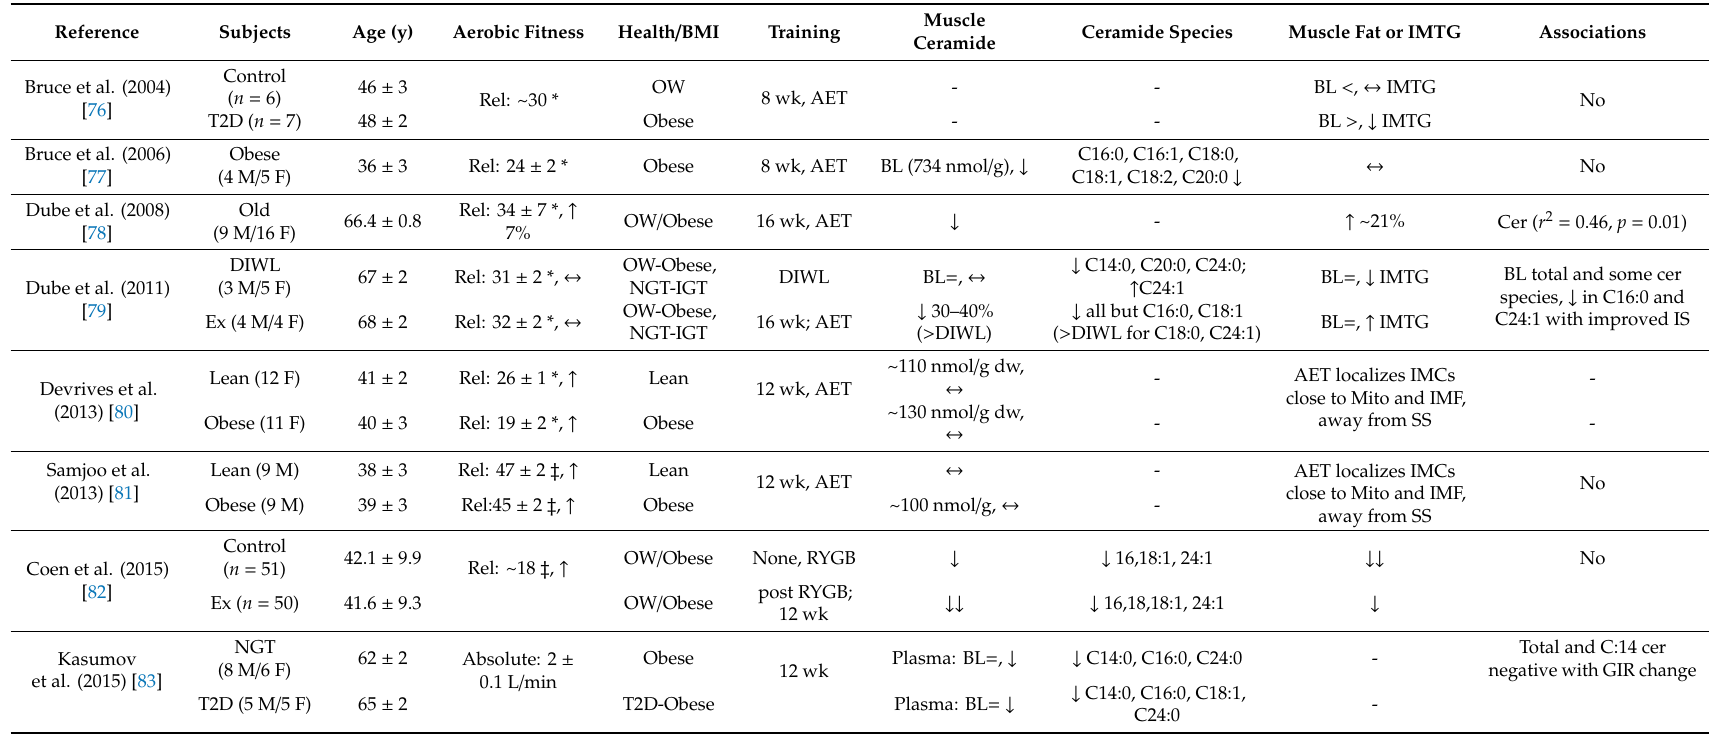
Table 4. Exercise training studies in